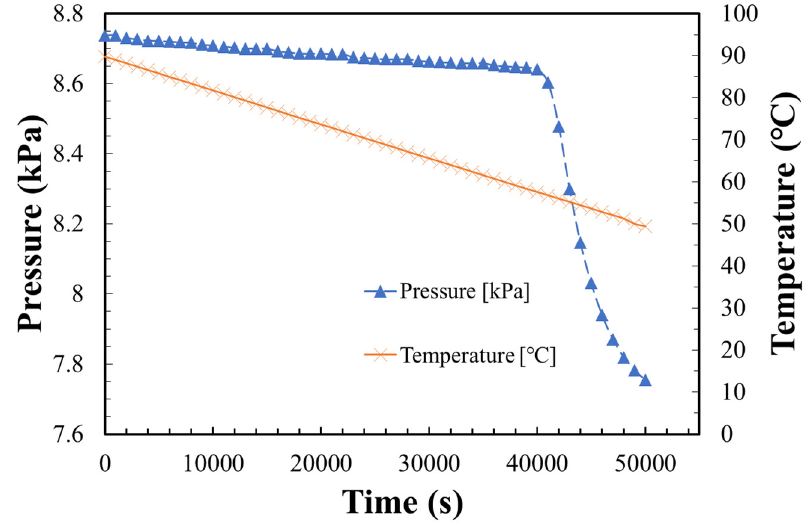
Figure 3. Pressure and temperature change in the measurement of the hydration reaction.